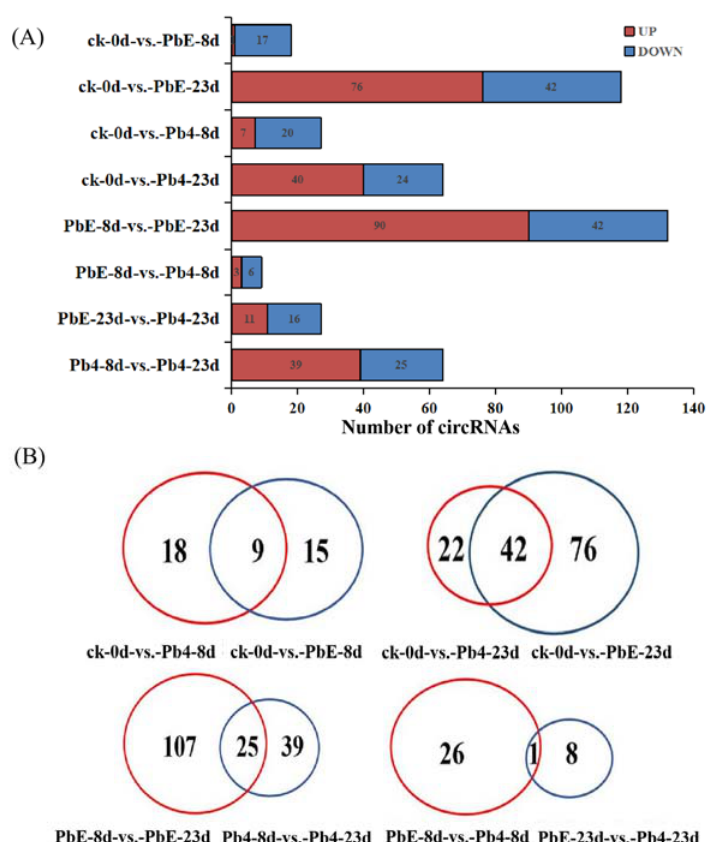
Figure 3. ( A ) Comparison of the number of circRNAs between control plants and plants infected with the two pathotypes of P. brassicae at 8 and 23 dpi. Blue and red represent up-and downregulated circRNAs, respectively. The results of 8 comparisons are shown. ( B ) Venn diagrams showing the overlaps of circRNAs differentially expressed in each comparison.